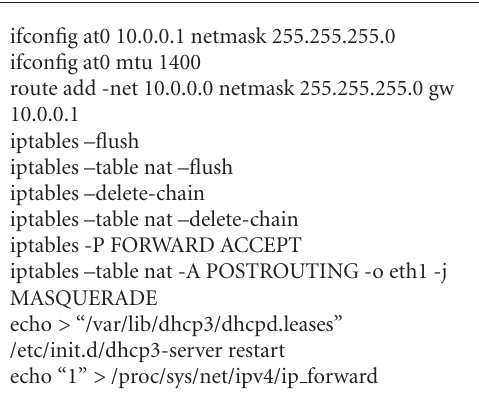
DHCP server is coded at the at0 interface (dhcpd.conf) as presented in Algorithm 2.